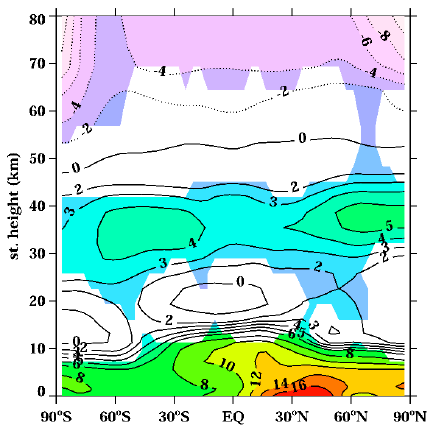
Figure 7. The annual and zonal mean ozone linear trend (% / 31 years) during 1910 to 1940 for the ALL experiment. The area where the trend is significant at the 90% or better level is marked by color shading.